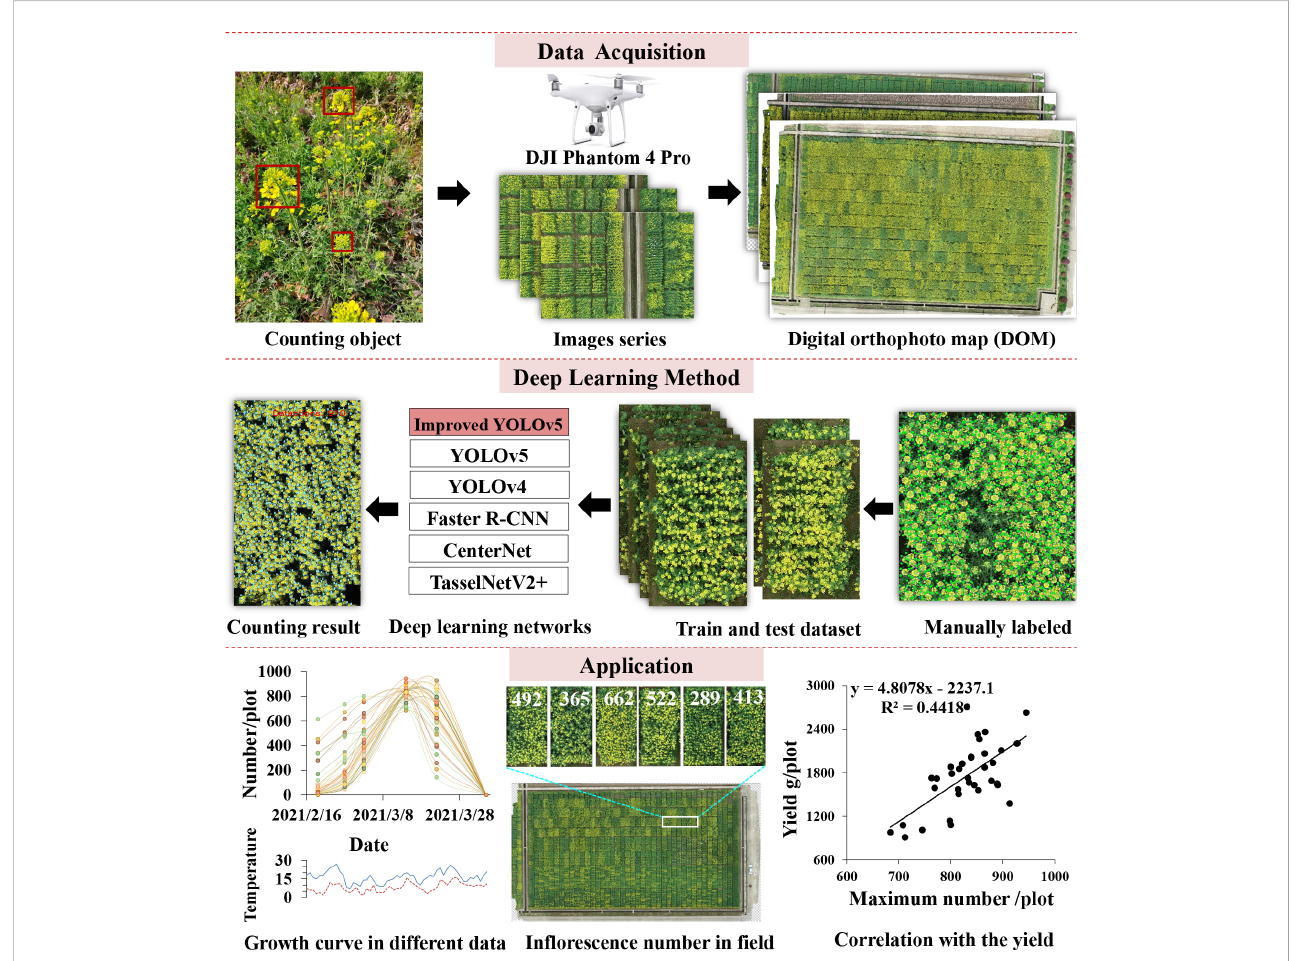
FIGURE 2 General frame diagram of this